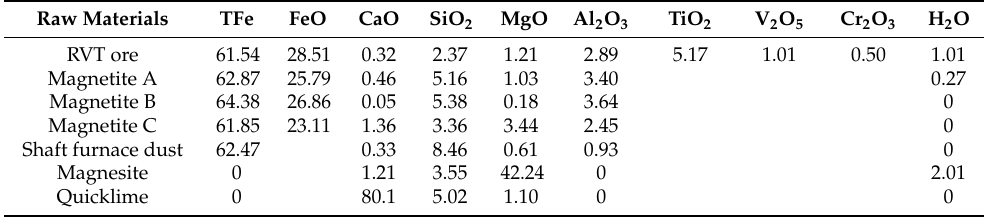
Table 1. Chemical composition of raw materials (mass, %).